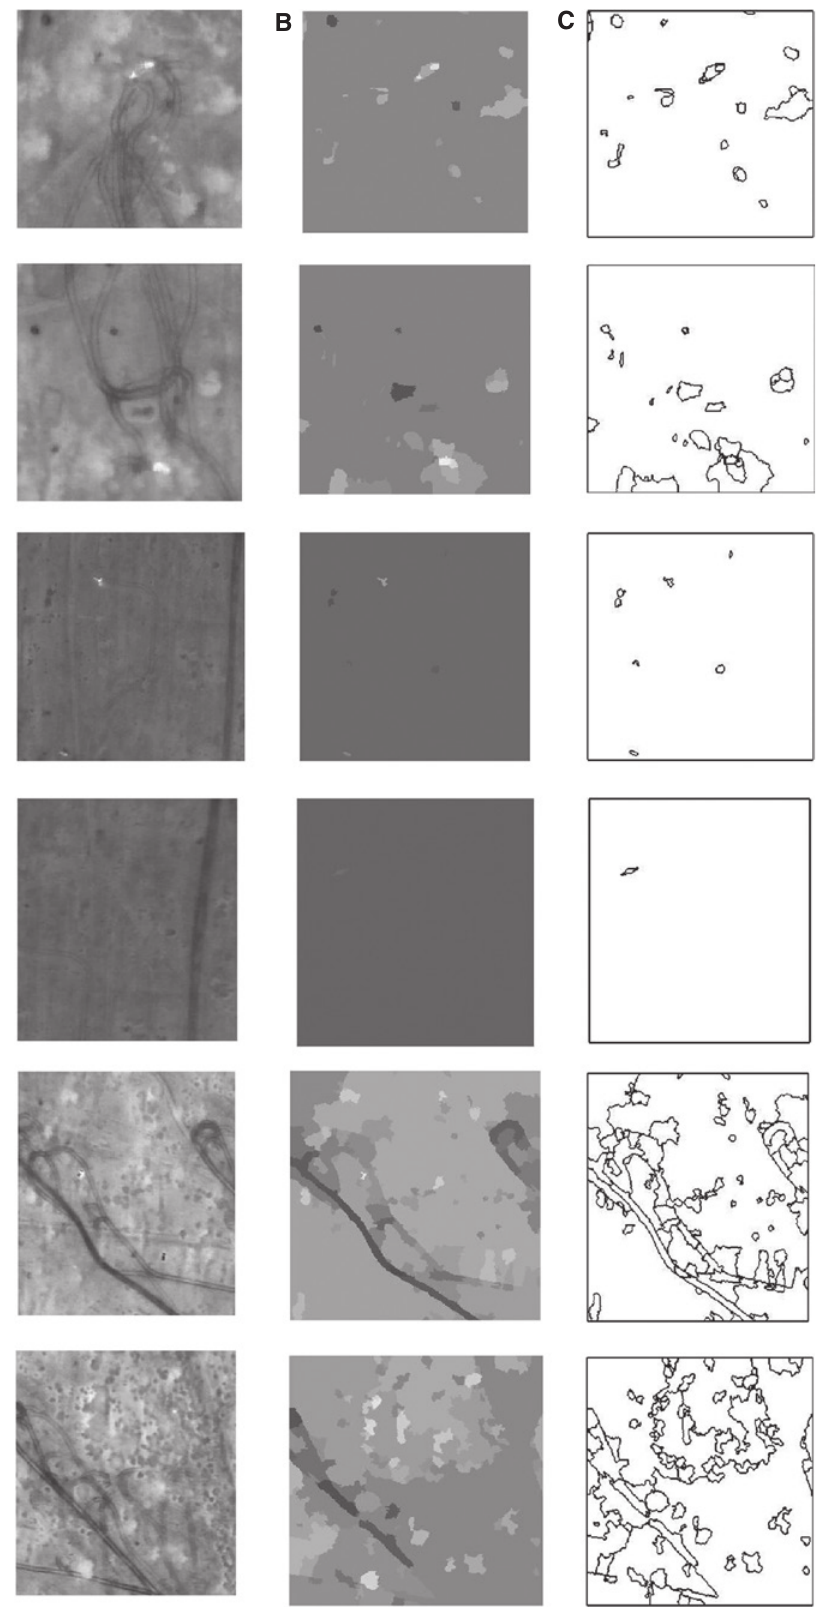
Figure 1: Image Segmentation Results. (A) Original Images. (B) Segmentation. (C) Boundary